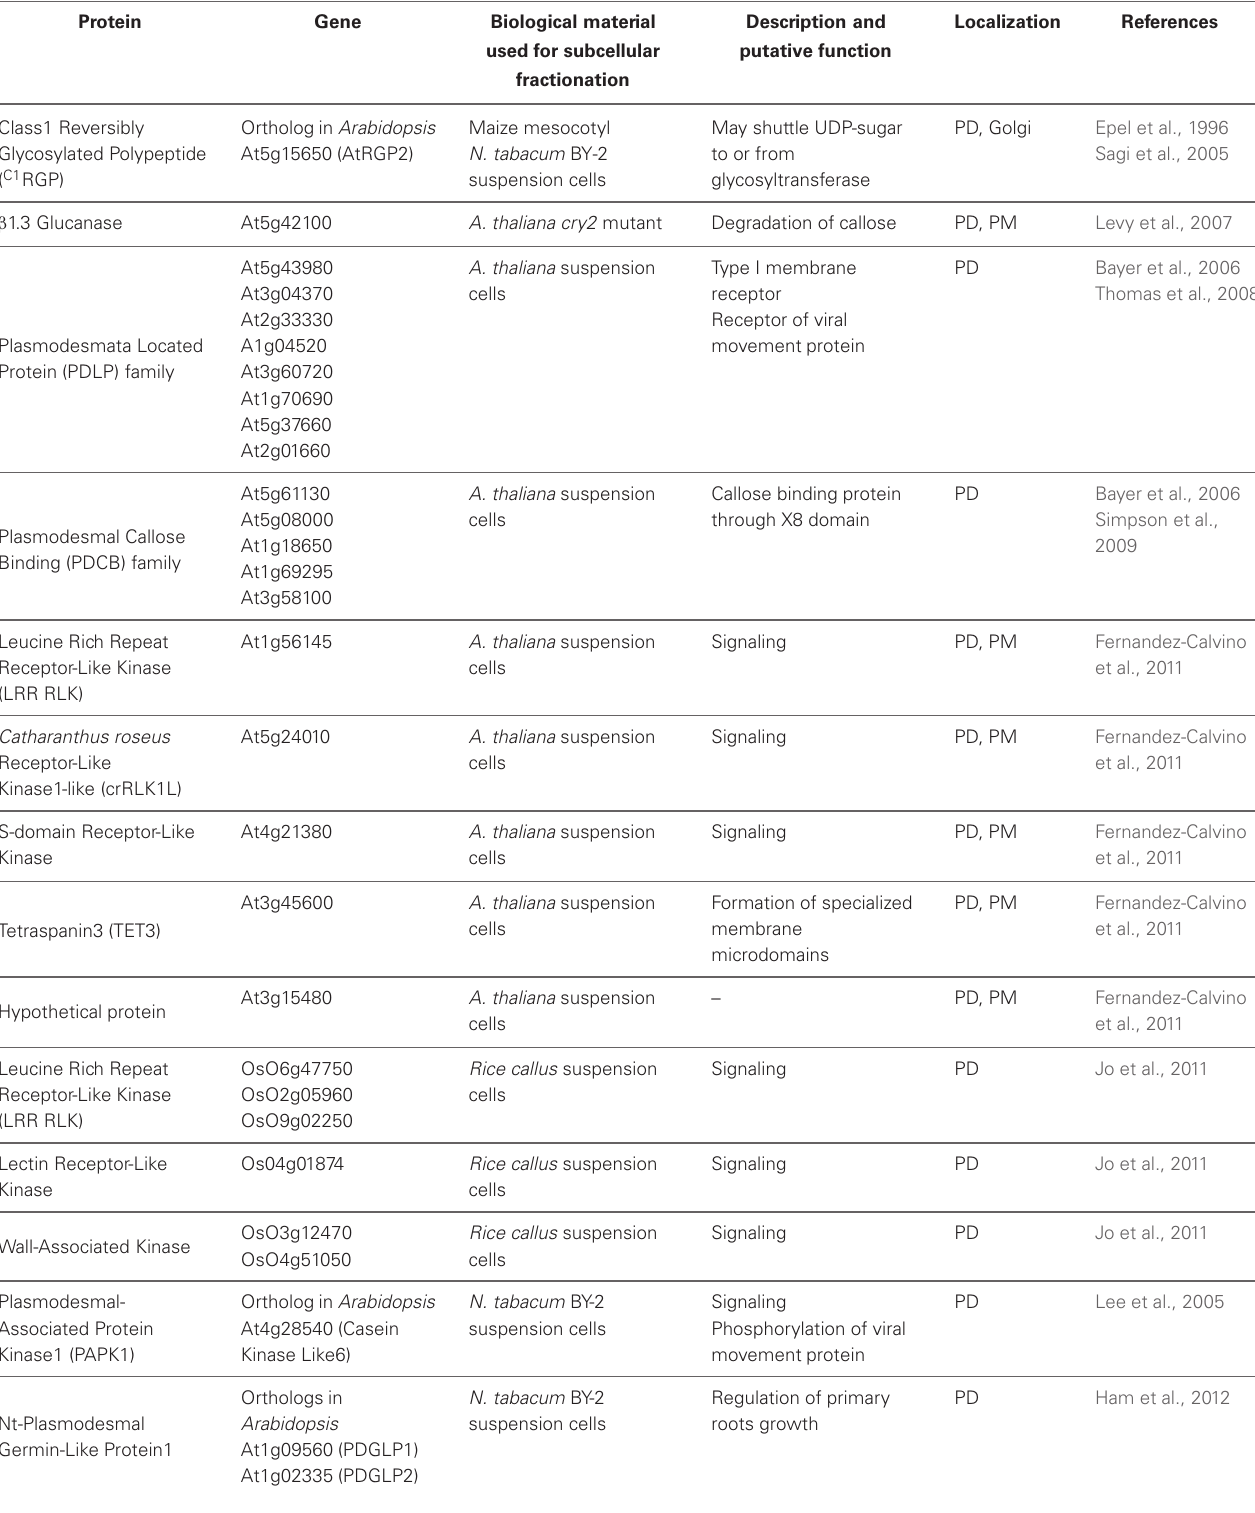
Table 1 | List of confirmed PD-associated proteins identified through subcellular fractionation and proteomic analysis.